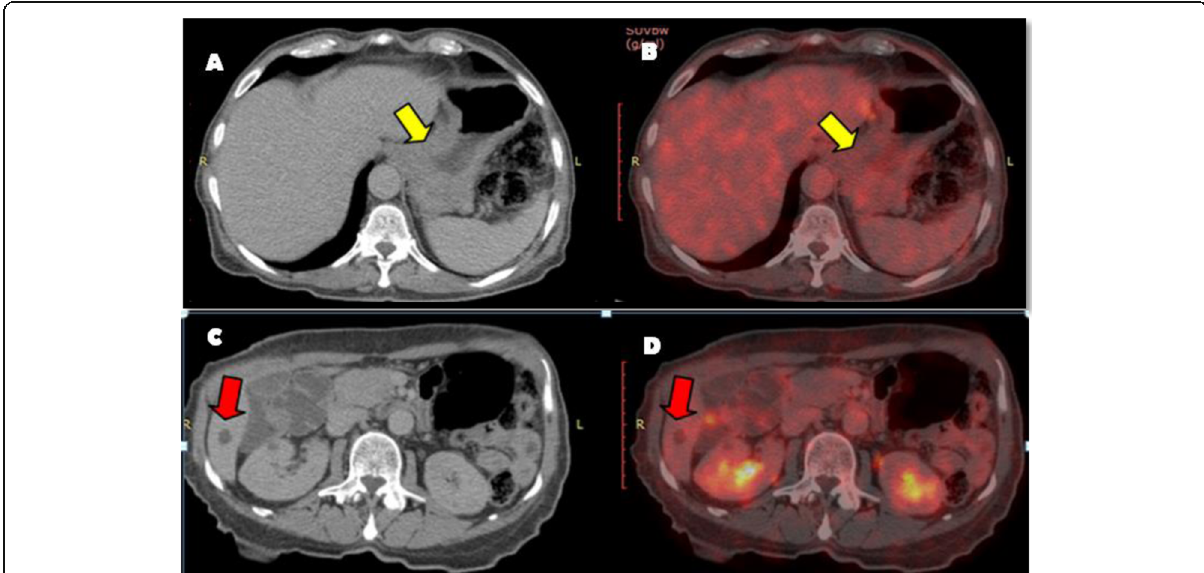
Fig. 2 Axial post-contrast CT and fused PET/CT images for a 68-year-old patient with a history of pathologically proven gastro-esophageal invasive moderately differentiated adenocarcinoma. He received chemotherapy and he was under follow-up. Images a and b showed an irregular circumferential mural thickening involving the gastro-esophageal junction extending to the gastric fundus and proximal body region with no related metabolic activity (yellow arrows). Images c and d showed a right hepatic hypodense focal lesion at segment VI, with no related